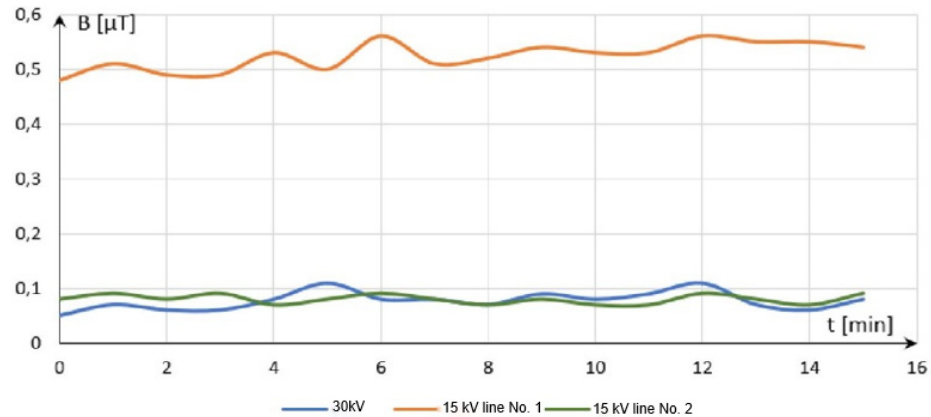
Figure 10. Magnetic field induction B change fluctuations under medium-voltage lines for the ELF range.